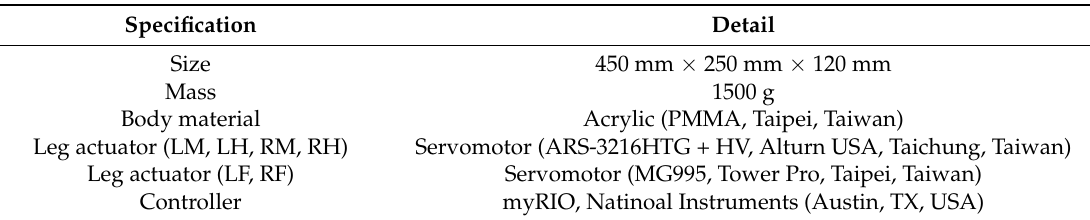
Table 1. Specification of the dung beetle